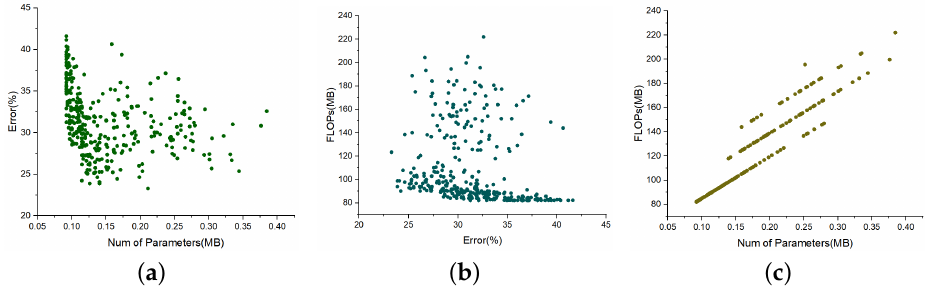
Figure 6. The pairwise relationships of three objectives on UniMiB-SHAR. ( a ) Change relation between number of parameters and error. ( b ) Change relation between error and FLOPs. ( c ) Change relation between number of parameters and FLOPs.